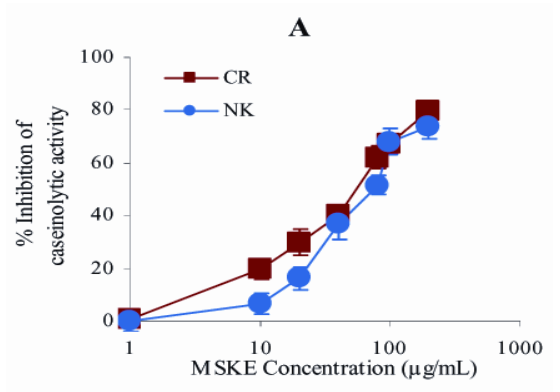
Figure 1. Semi  log plots of in vitro inhibition of caseinolytic activity of CR (50 μ g) and NK (500 μ g) venoms by MSKE (A), EDTA and the phenolic principles of MSKE (B, C). Values are mean ± S.E.M. of at least duplicate